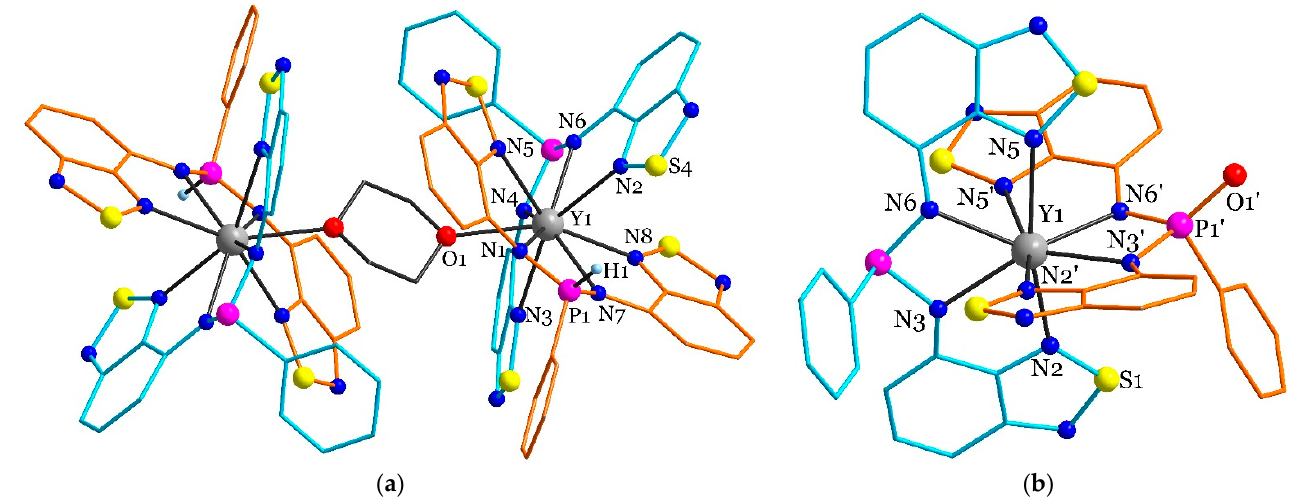
Figure 3. The structures of ( a ) [ 5 2 ·(µ-dioxane)]·dioxane and ( b ) the complex anion in 6 ·hexane and 6 ·1.5thf on the example of the oxygen-containing molecule of the former, according to XRD. Solvate molecules, the counterion, disordered parts, and hydrogen atoms are omitted. Different L/HL ligands are coloured with orange or blue. Selected distances for ( a ) (Å): Y1–N1 2.496(2); Y1–N2